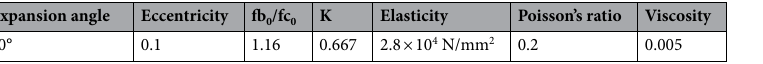
Table 1. Concrete property parameters in simulation. f b0 /f c0 is the ratio of biaxial and uniaxial compressive strengths; parameter K determines the yield surface shape and is defined as 2/3. And ultimate tensile strength is 1.78 N/mm 2 .